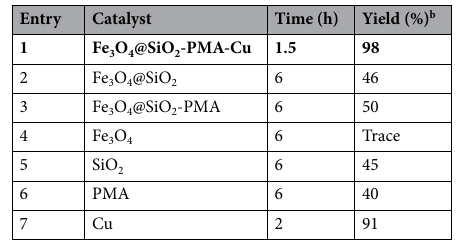
Table 2. Investigation of the catalytic effects of Fe 3 O 4 @SiO 2 -PMA-Cu components on the model reaction. All reactions were carried out in the presence of 0.1 g catalyst at 55 °C. a Isolated yields. Significant values are in